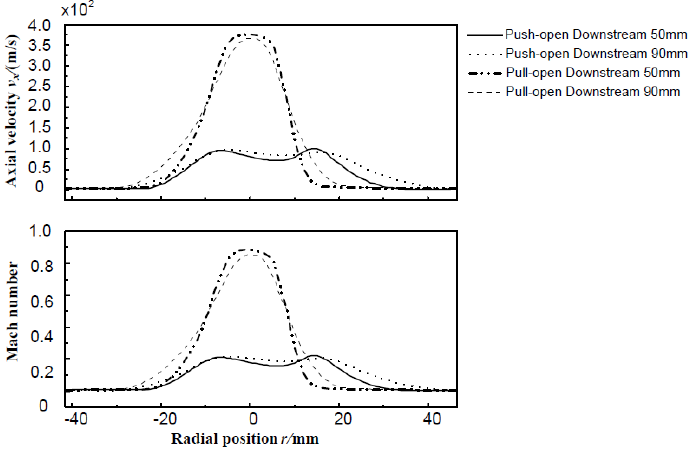
Figure 14. Radial distribution of the axial velocity and Mach number on the section 50 mm and 90 mm downstream the outlet.